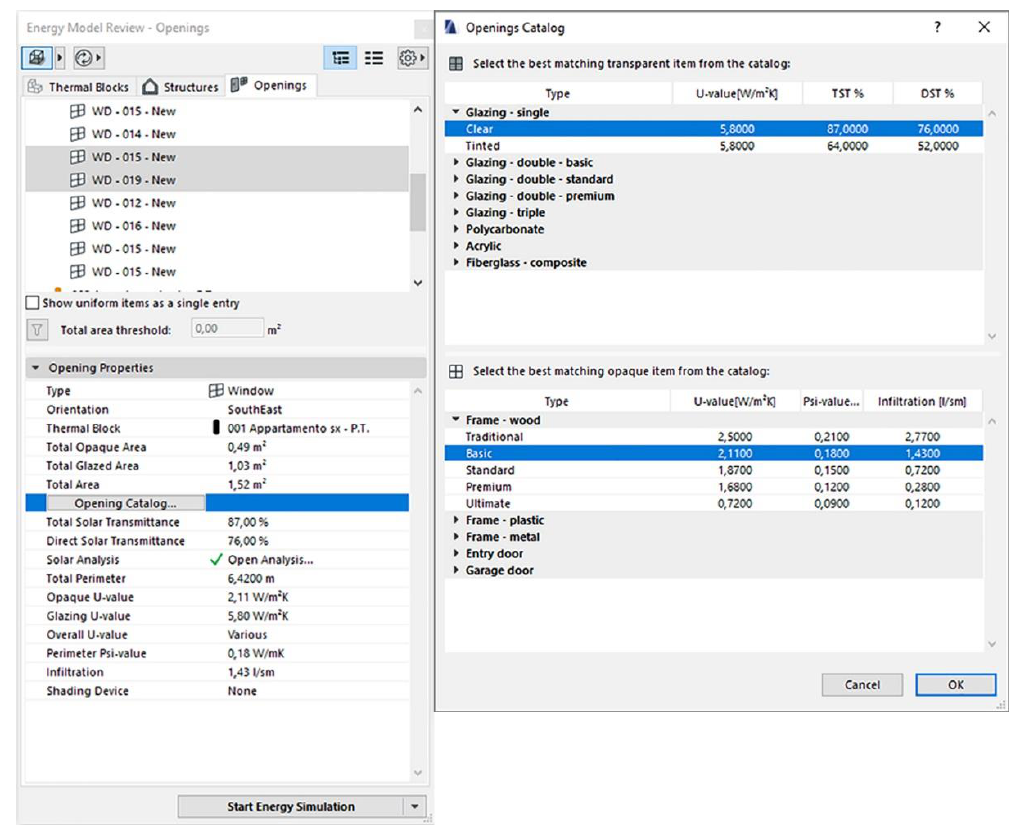
Figure 16. Window for selecting openings/frames on the left, library of the glass type and frame material on the right.